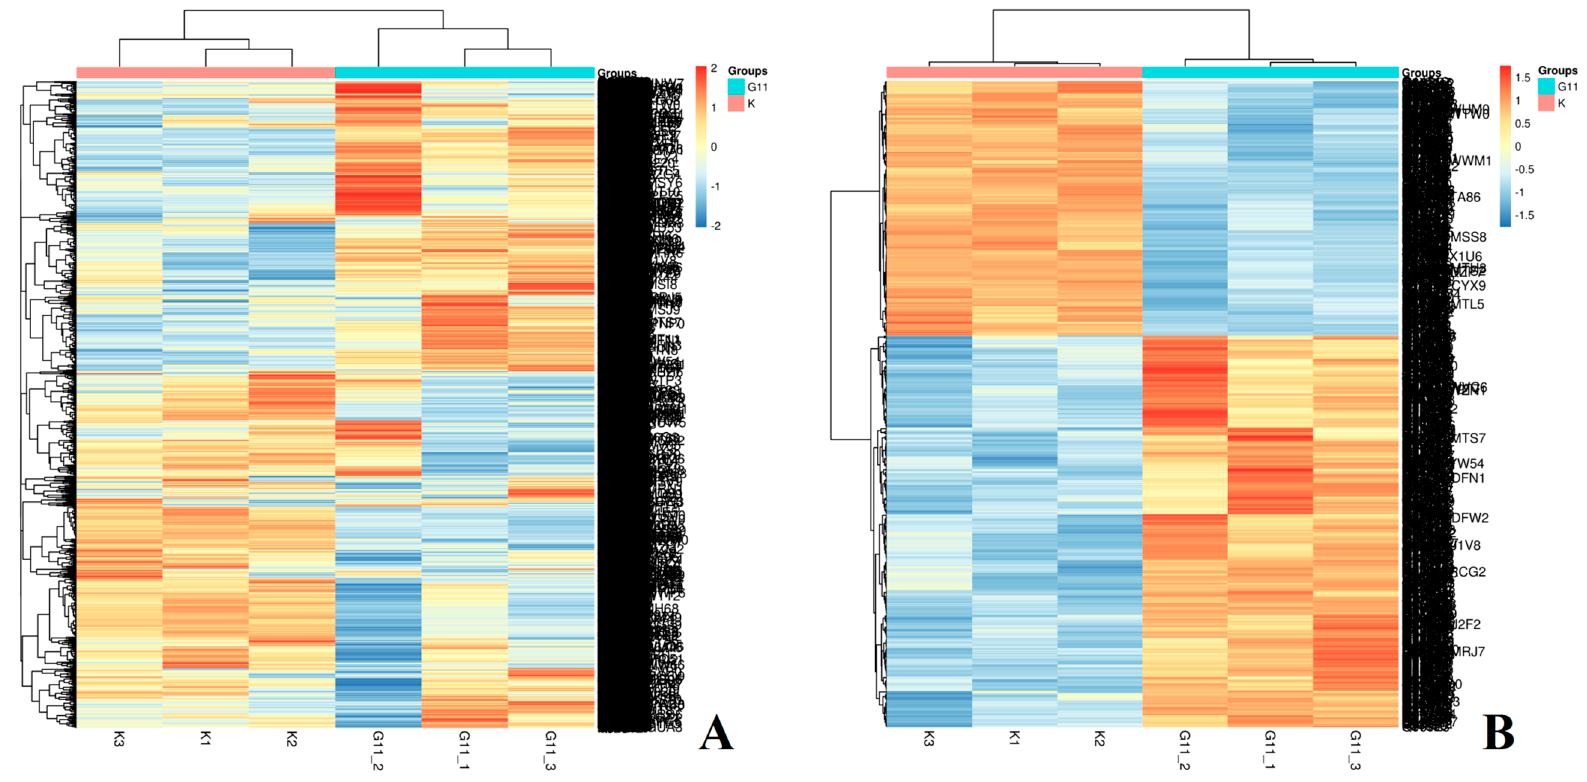
Figure 3. The hierarchical clustering of total protein ( A ) and differentially expressed proteins ( B ). * K1,2,3 are the three control groups; G11-1, -2, -3 are the three administered groups ( n = 3).